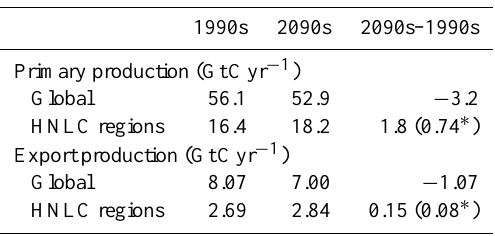
Table 1. Globally integrated primary and export production rates simulated by the model.